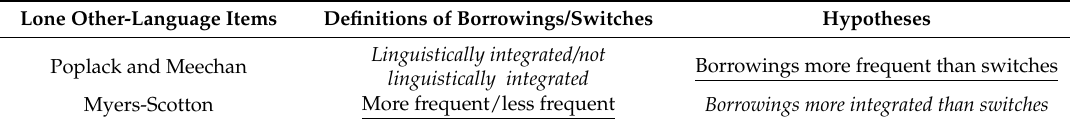
Table 2. Definitions vs. hypotheses: Poplack and Meechan [2] vs. Myers-Scotton